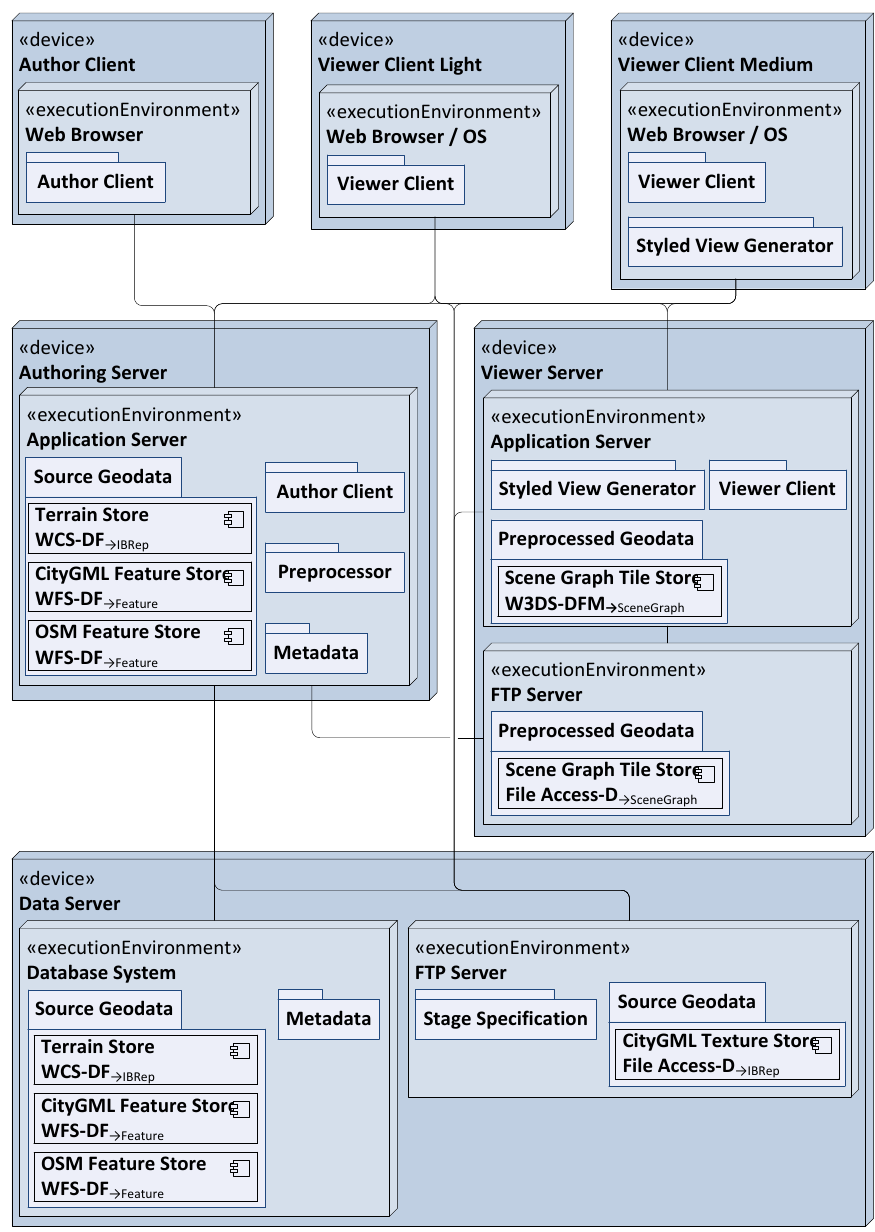
Figure 11. Deployment diagram depicting a mapping of the logical software architecture (Figure 10) to a physical